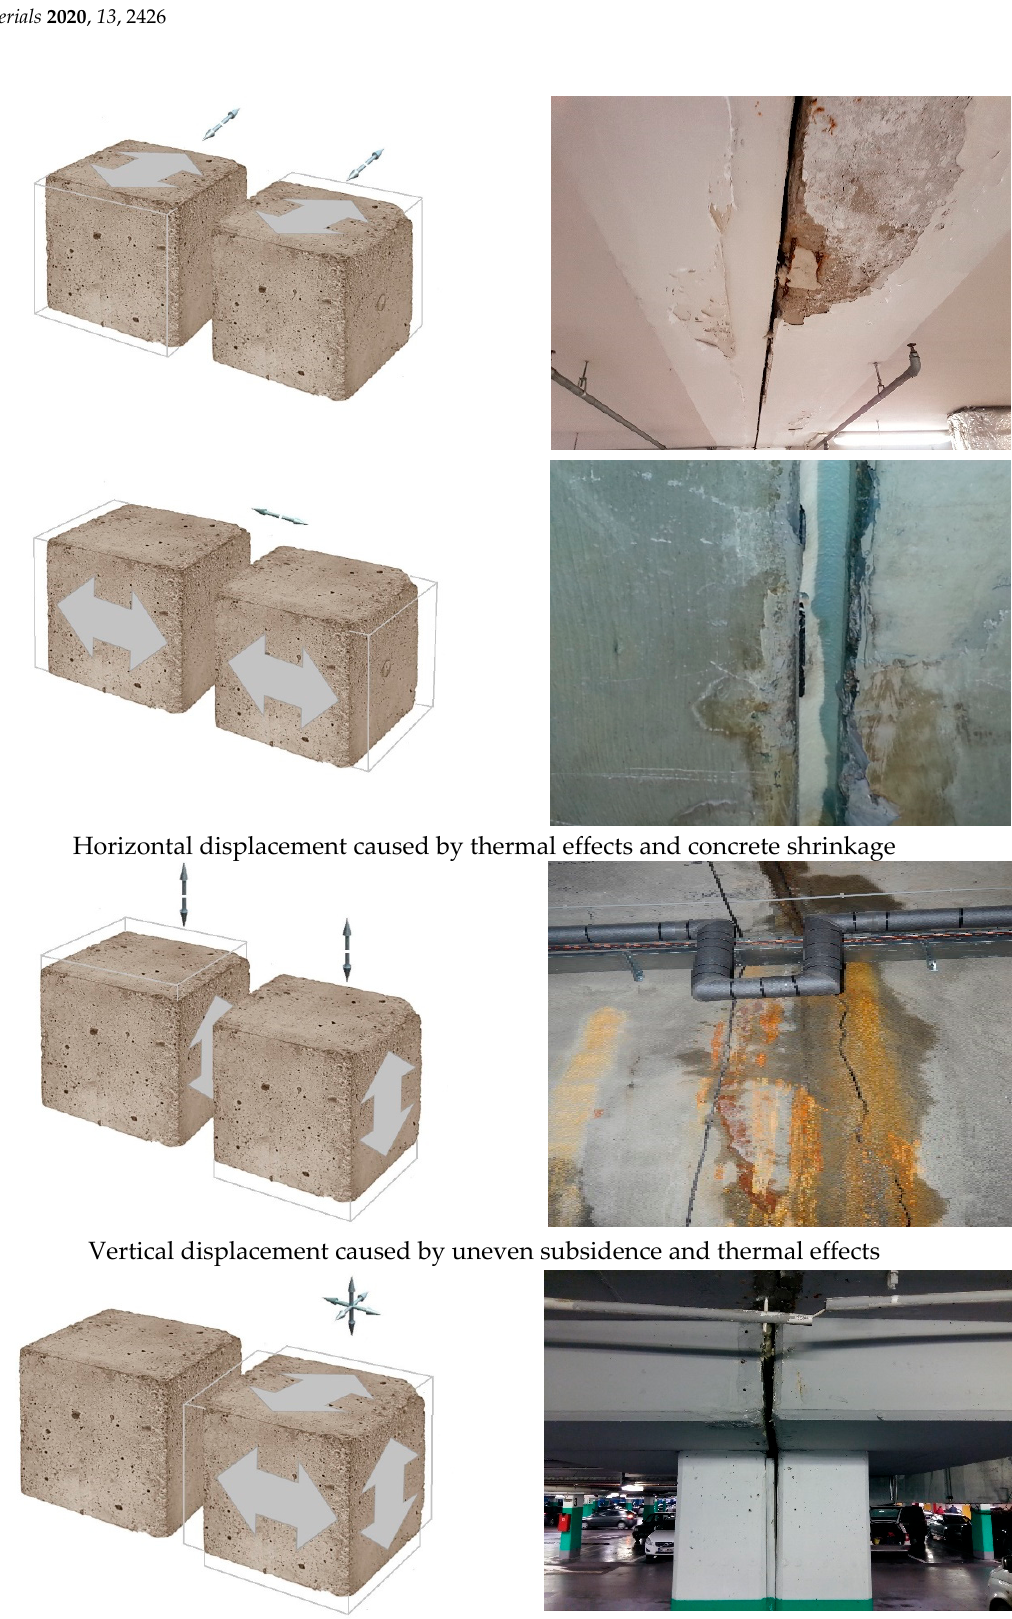
Figure 1. Models showing possible displacements of structural members at expansion joint.